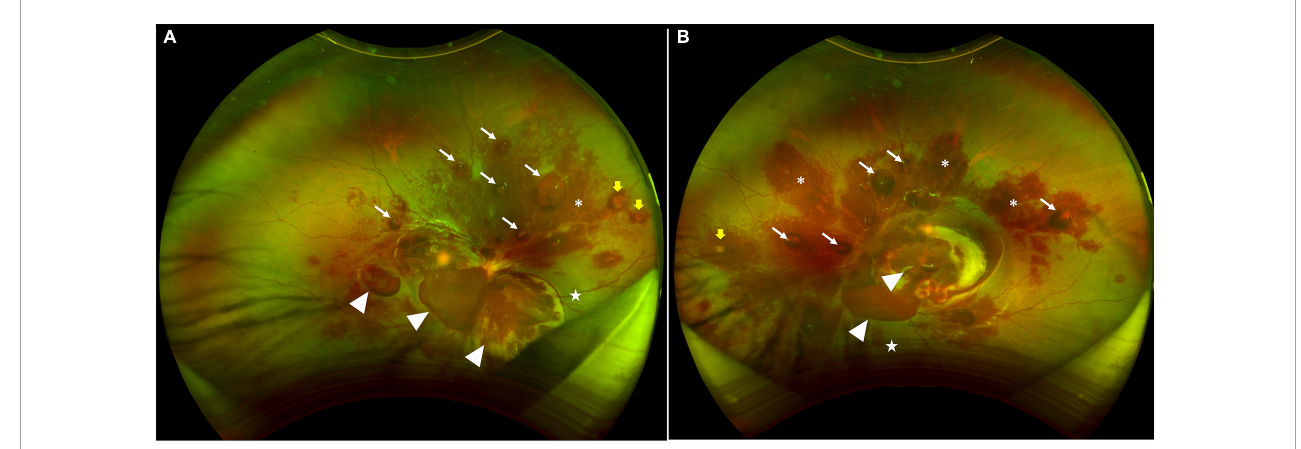
FIGURE1 Scanning laser ophthalmoscopic images showing extensive dense preretinal, intraretinal, and subretinal hemorrhages in both retinas. (A) The right eye shows subhyloid hemorrhages (white arrows), hemorrhages between ILM and retina (white arrow heads), hemorrhages within the retina (asterisks), and sub-retinal hemorrhages (stars). Yellow arrows point at Roth spots. (B) The left eye shows subhyloid hemorrhages (white arrows), hemorrhages between ILM and retina (white arrow heads), hemorrhages within the retina (asterisks), at sub-retinal hemorrhages (stars). Yellow arrows point at Roth spots.